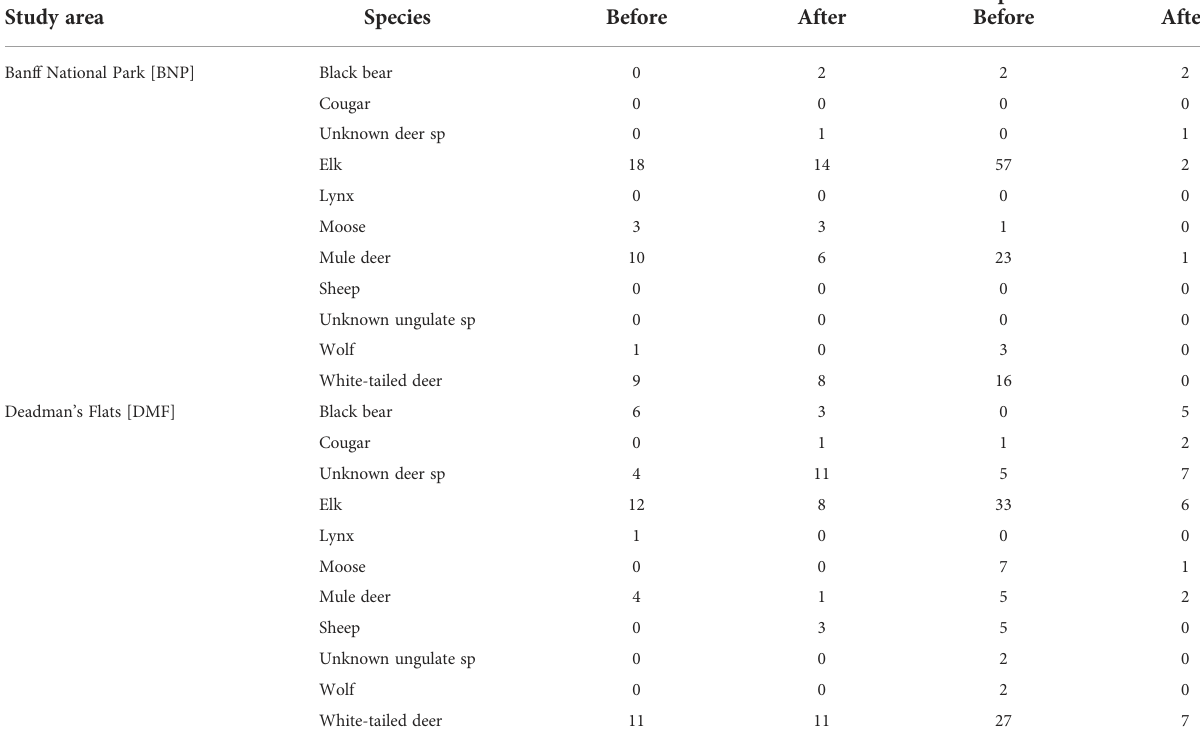
TABLE 1 Summary of wildlife – vehicle collision data collected between 1988 and